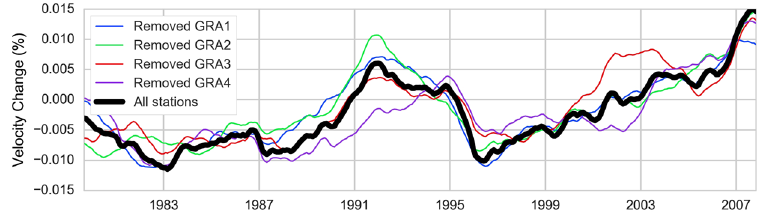
Figure 3. Observed relative velocity dv/v using all six station pairs (black) and dv/v calculated if data from one station is removed from the calculation (i.e. three station pairs